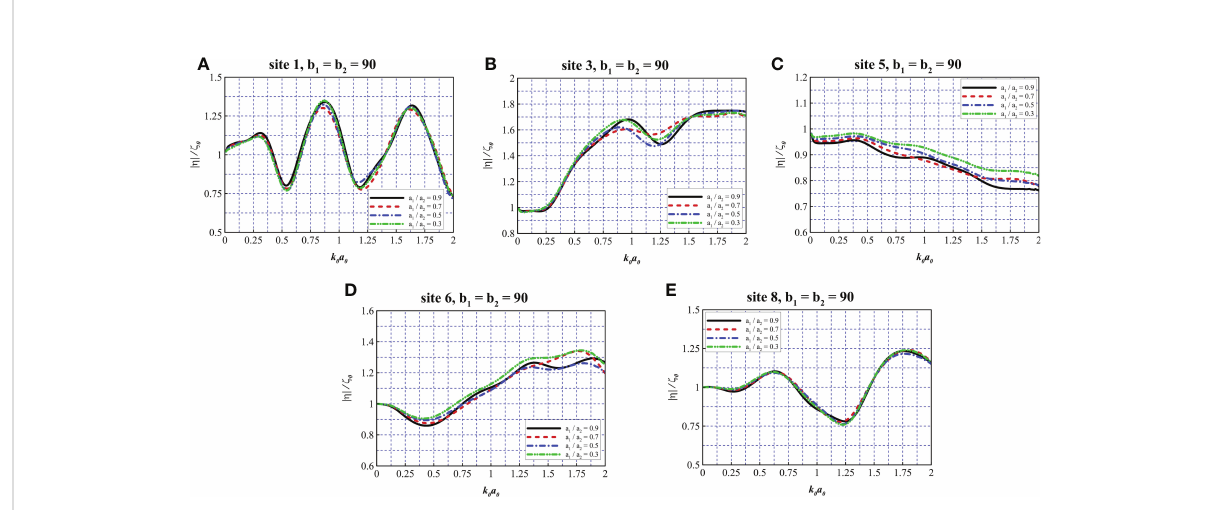
FIGURE 11 Comparison of wave elevation at different measurement sites with various net spacing. (A – E) b1 = b2 =90, site 1, 3, 5, 6, 8.